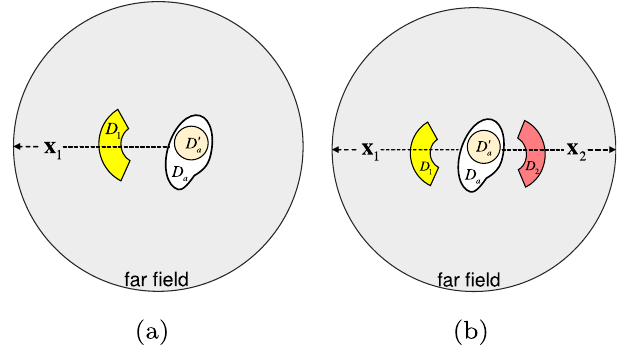
Figure 3. Sketch of the top view of the problem geometry showing the near control(s) and the far fi eld direction(s). (a) One near control and one far fi eld direction. (b) Two near controls and two far fi eld